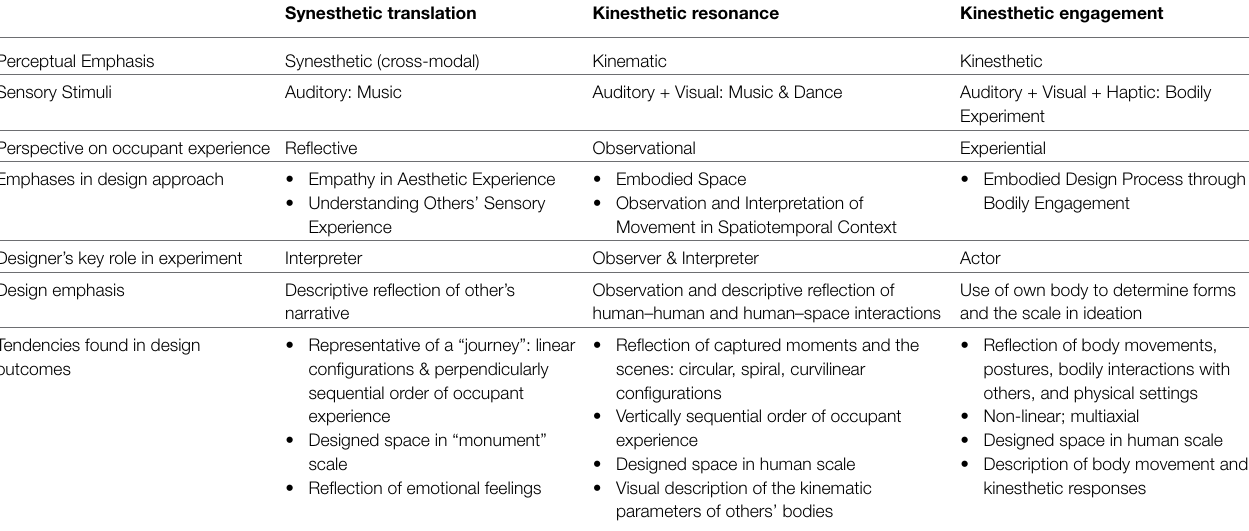
TABLE 1 | Construct of three design thinking models: synesthetic translation, kinesthetic resonance, and kinesthetic engagement. Synesthetic